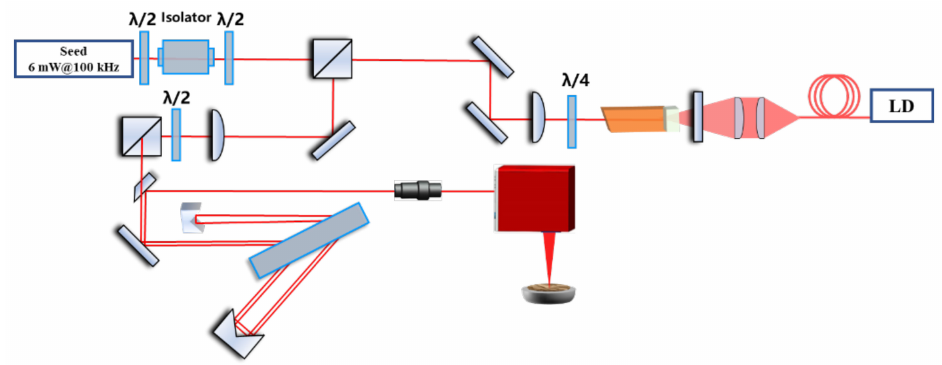
Figure 3. Schematic diagram of the femtosecond laser